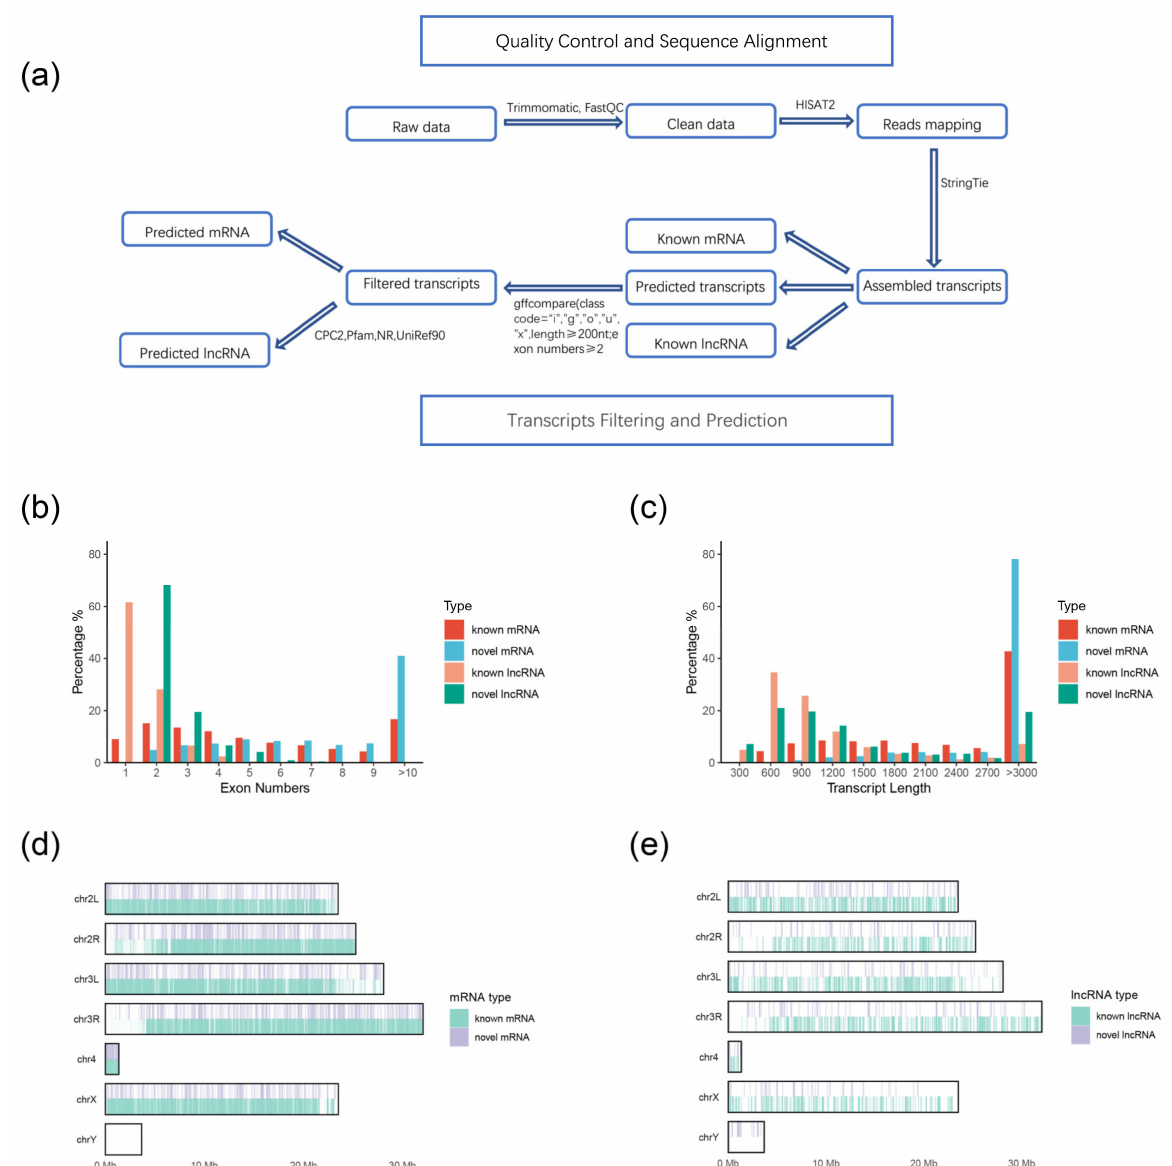
Figure 2. Identification and genomic characteristics of mRNAs and lncRNAs ( a ) Overview of the identification pipeline for putative mRNAs and lncRNAs in ISWI mutant Drosophila . ( b ) Distribution of exon numbers in mRNAs and lncRNAs. ( c ) Distribution of transcript length in mRNAs and lncRNAs. ( d ) The number distribution of mRNAs on the chromosome. ( e ) The number distribution of lncRNAs on the